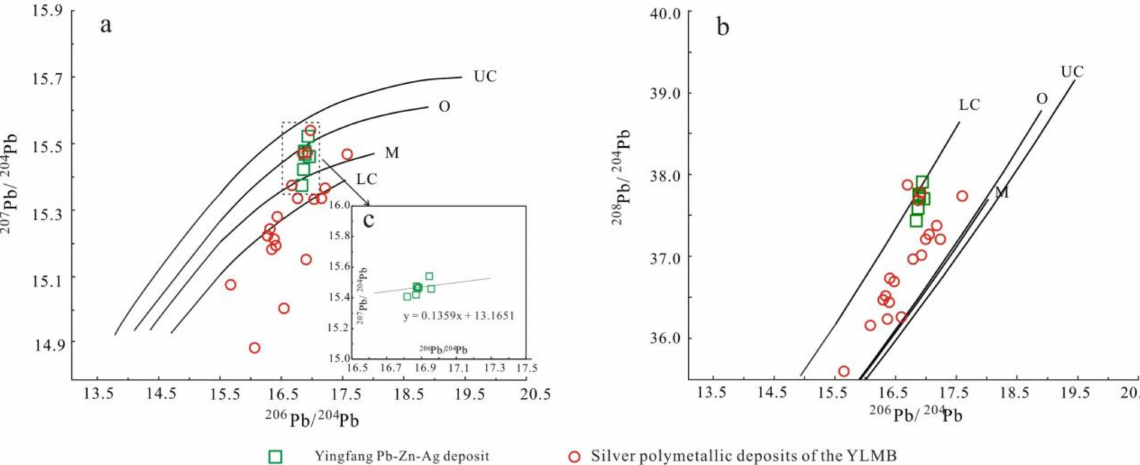
Figure 8. Lead isotopic composition of sulfides from the Yingfang deposit and other deposits on the Yanshan–Liaoxi metallogenic belt (YLMB). ( a ) Lead isotope discriminate diagram of 207 Pb/ 204 Pb versus 206 Pb/ 204 Pb from [61]; ( b ) Lead isotope discriminate diagram of 208 Pb/ 204 Pb versus 206 Pb/ 204 Pb diagram from [61]. ( c ) Lead isotope discriminate diagram of 207 Pb/ 204 Pb versus 206 Pb/ 204 Pb from [58]. O, orogen; M, mantle; UC, upper crust contributed to the orogen; LC, lower crust contributed to the orogen. Dotted curves show the lead evolutions fit the data. Data sources and deposit numbers are listed in Table 1.